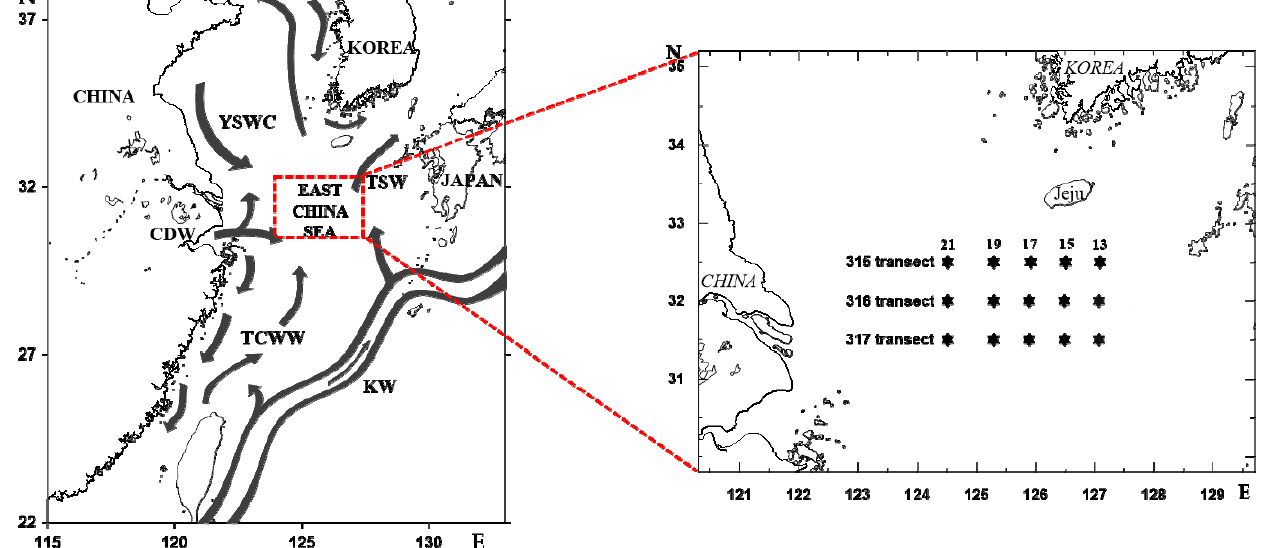
Figure 1. Sampling station in the northern East China Sea, 2016–2020. CDW: Changjiang diluted water; YSWC: Yellow Sea cold water; KW: Kuroshio water; TCWW: Taiwan current warm water; TSW: Tsushima surface water. Table 1. Description of the sampling sites in the northern East China Sea for the cruise period from